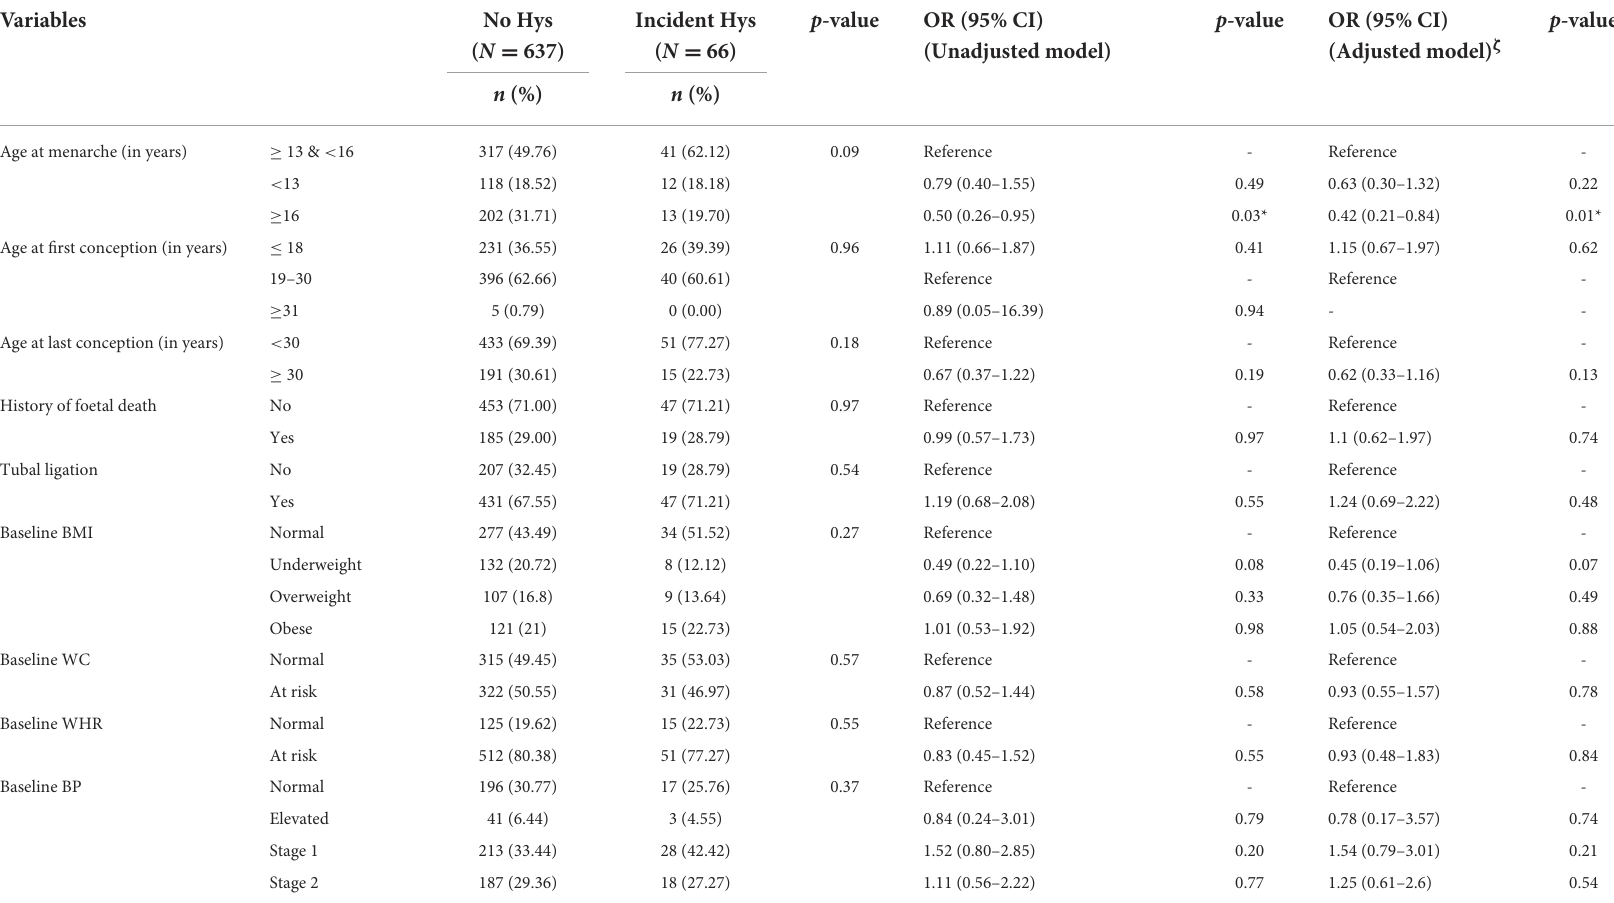
TABLE 3 Distribution and association of reproductive events, baseline obesity variables, blood pressure status, and biochemical determinants among women with no history of hysterectomy and incident hysterectomy in the end-line assessment.